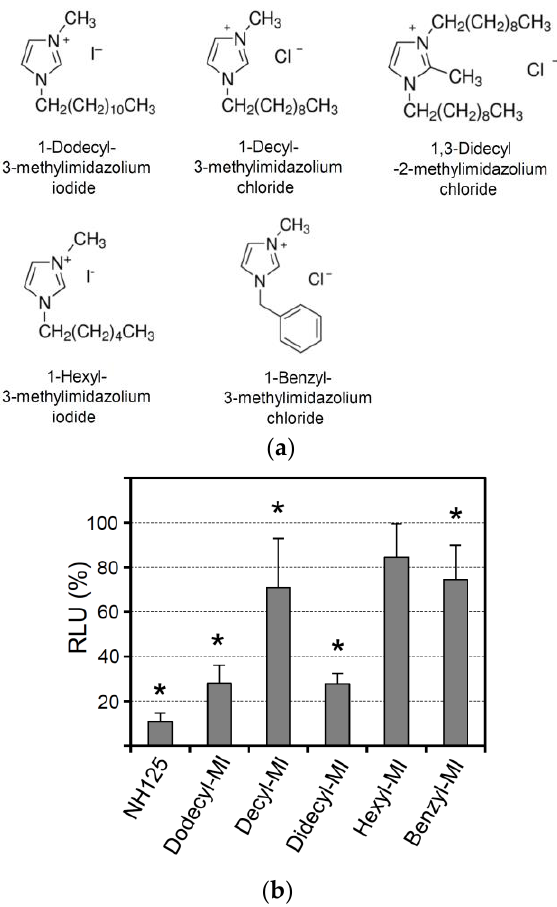
Figure 3. Antiviral activity of NH125-related imidazolium derivatives. ( a ) Chemical structures of 1-dodecyl-3-methylimidazolium iodide, 1-decyl-3-methylimidazolium chloride, 1,3-dicyl-2-methylimidazolium chloride, 1-hexyl-3-methylimidazolium iodide, and 1-benzyl-3-methylimidazolium chloride. ( b ) Vero cells were treated for 1 h with the indicated compounds (10 µM) and subsequently infected with VSV* ∆ G(sNLuc) as described in the legend for Figure 2. Secreted NanoLuc luciferase activity was determined in the cell culture supernatant 6 h p.i. Mean values and standard deviations of three experiments are shown. Asterisks indicate significant inhibition of virus infection compared to DMSO-treated cells.